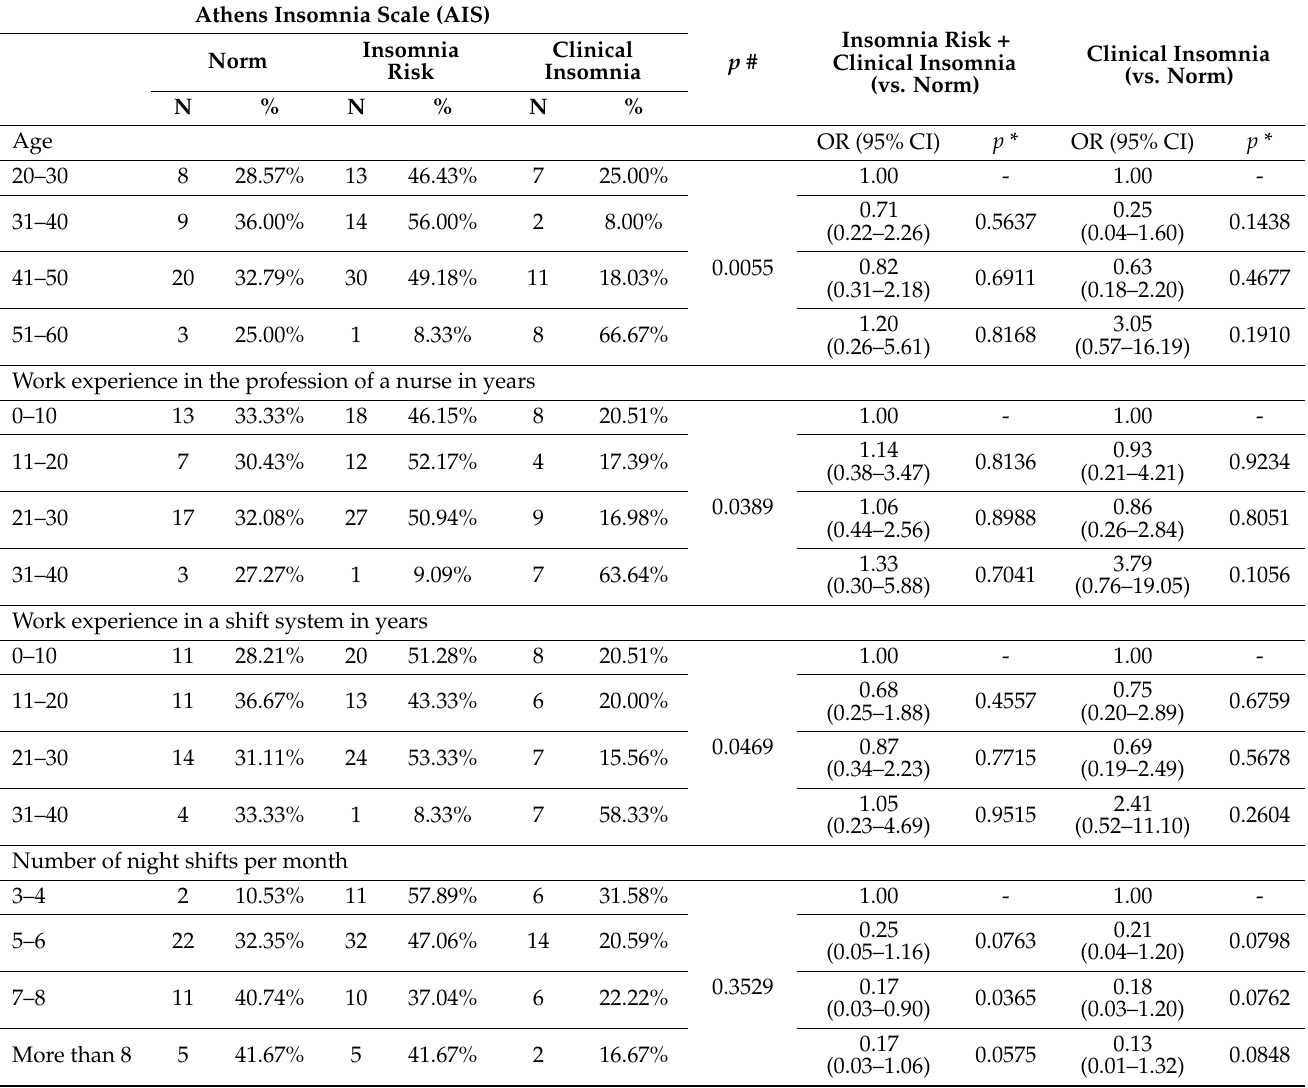
Table 1. Age and seniority in the shift system of the surveyed